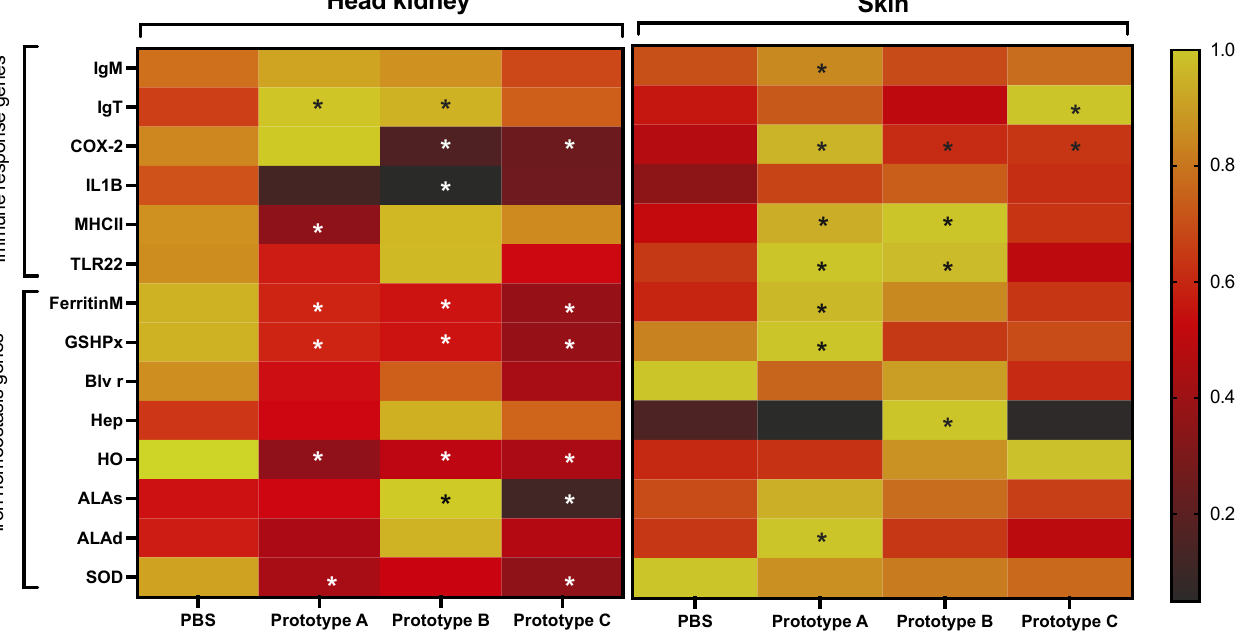
Figure 8. RT-qPCR analisys of S. salar response C. rogercresseyi infestation. The heatmap shows the relative expression levels. Asterisks showed significant differences concerning the control group (PBS: phosphate-buffered saline) at p -value < 0.05, black asterisks upregulation, white asterisks downregulation.